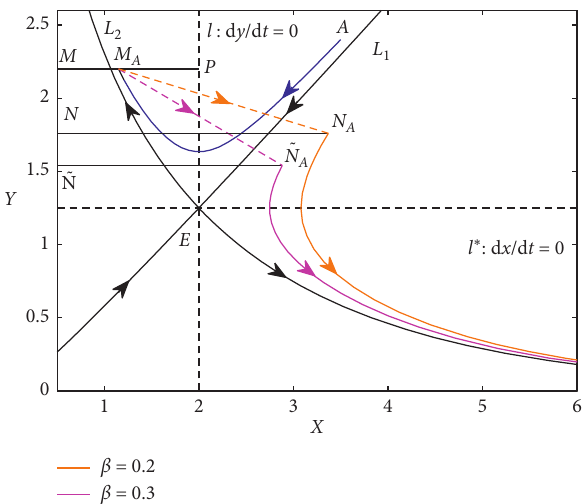
Figure 9: Situations of impulsive model (2) when α � 1 . 4 with parameter values: a � 5 , c � 4 , d � 6 ,e � 3 , and h � 2 . 2 and initial values ( 3 . 5 , 2 . 4 ) . The case of β � 0 . 2 is shown in hazel line while that of β � 0 . 3 is exhibited in pink